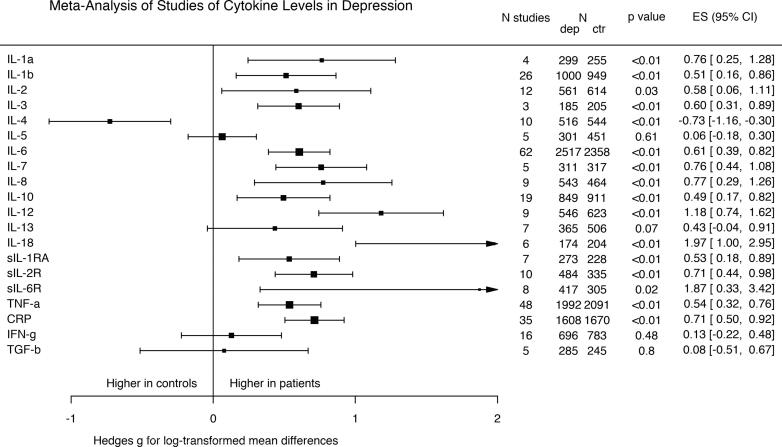
Forest plot showing effect sizes for mean differences in immune parameters in depression compared with healthy controls. There were significantly higher levels in patients with depression compared with controls for IL-1 α; IL-1 β; IL-2; IL-3; IL-6; IL-7; IL-8; IL-10; IL-12; IL-18; IL-1Ra; IL-2R; IL-6R; TNF α; and CRP. There was a significant reduction in IL-4 in patients compared with controls. There was no significant difference in TGF β; IFNγ; IL-13; IL-5 in patients compared with controls.